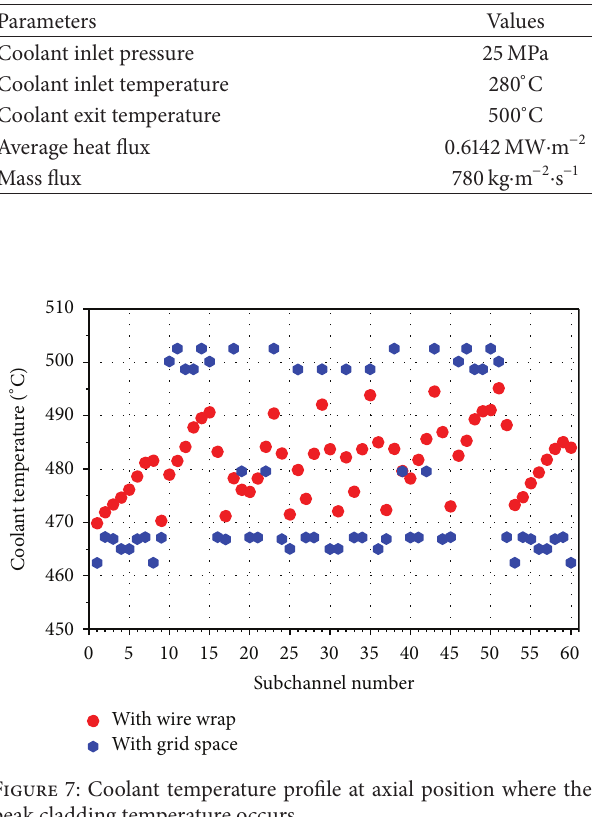
Figure 7: Coolant temperature profile at axial position where the peak cladding temperature